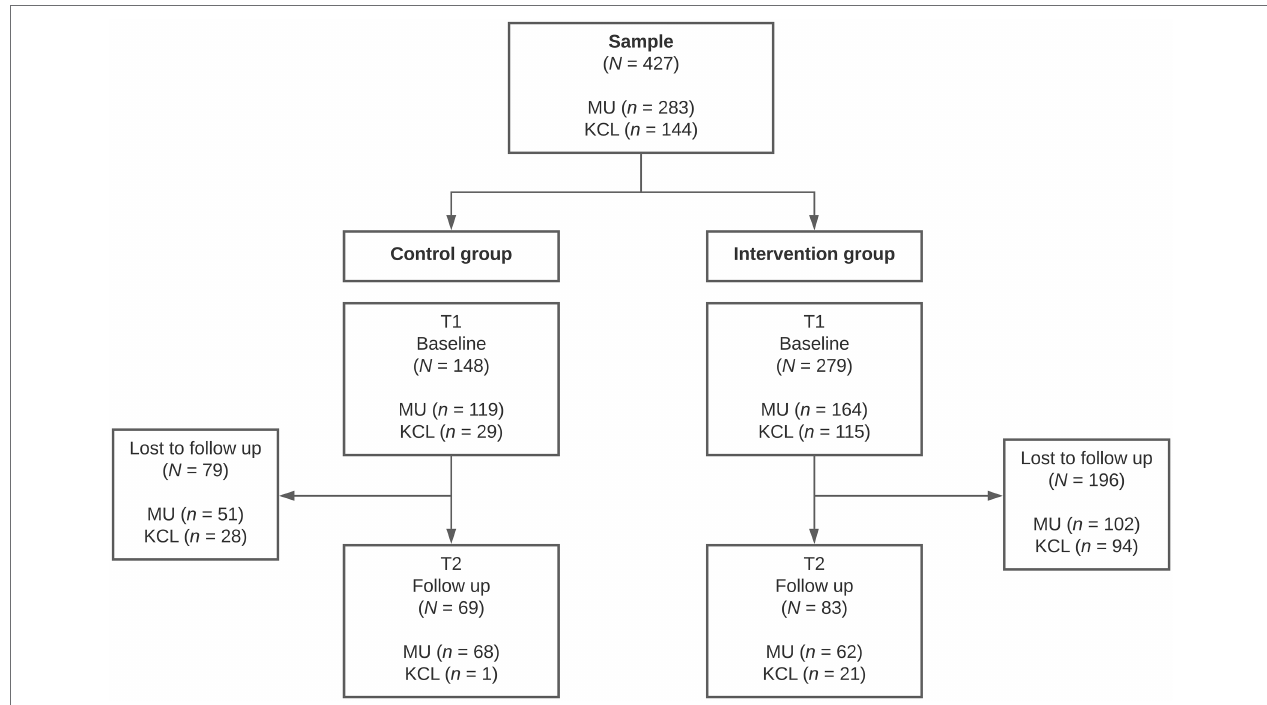
FIGURE 1 | Participant flow chart representing the sample size of each condition and participants lost to follow-up. MU, Monash University Australia; KCL, King’s College London; T1, Time 1; and T2, Time